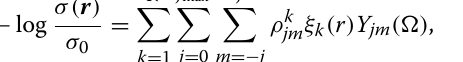
Fig. 2 One block of the inverse covariance matrix corresponding to time level 2018.0, CI model 0513, after normalization and time-averaging